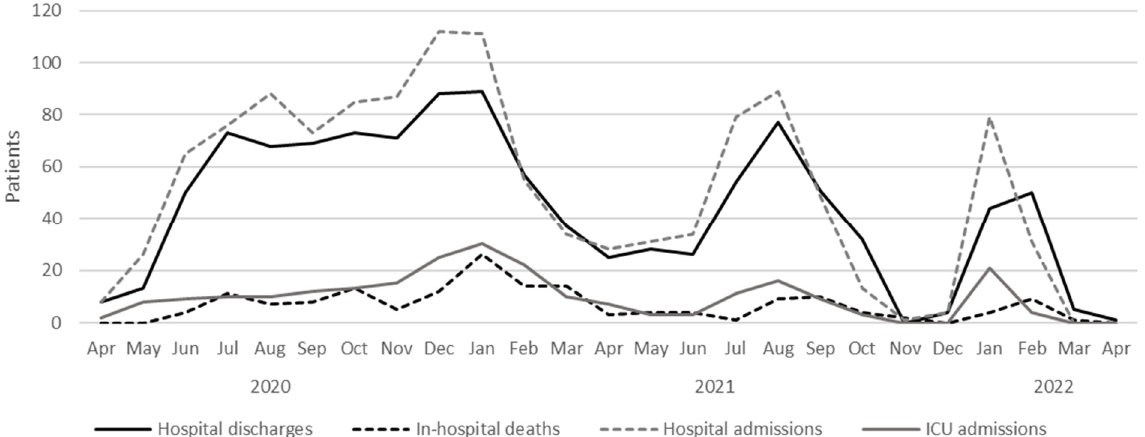
Figure 1. Number of hospital discharges, in-hospital deaths, hospital admissions, and ICU